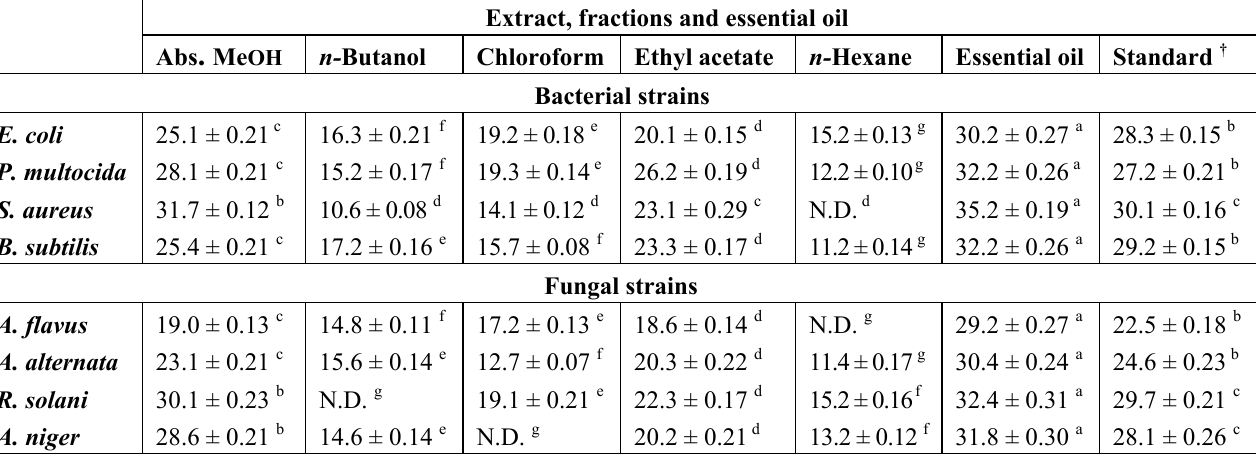
Table 3. Antimicrobial activity in terms of inhibition zone (mm) of M. goodenifolius plant extract and fractions at 20 mg/mL against selected bacterial and fungal